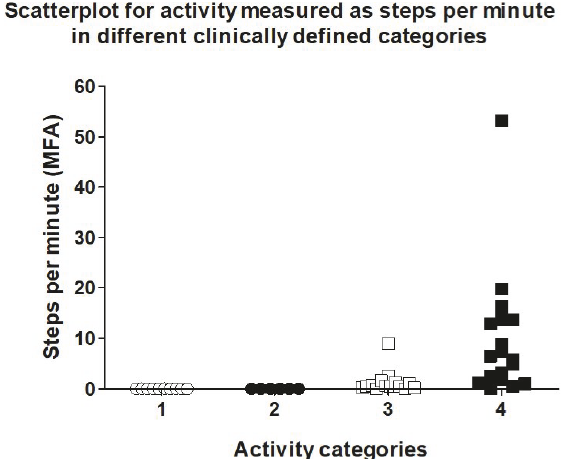
Figure 1: The chart shows the steps per minute during different clinically defined activity categories using a Misfit Shine worn at the ankle (MFA).